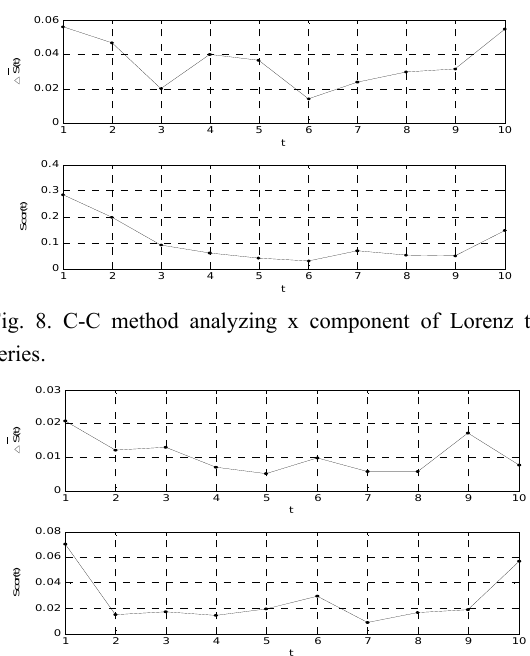
Fig. 9. C-C method analyzing Mackey-Glass time series. Fig. 10. C-C method analyzing x component of Henon time